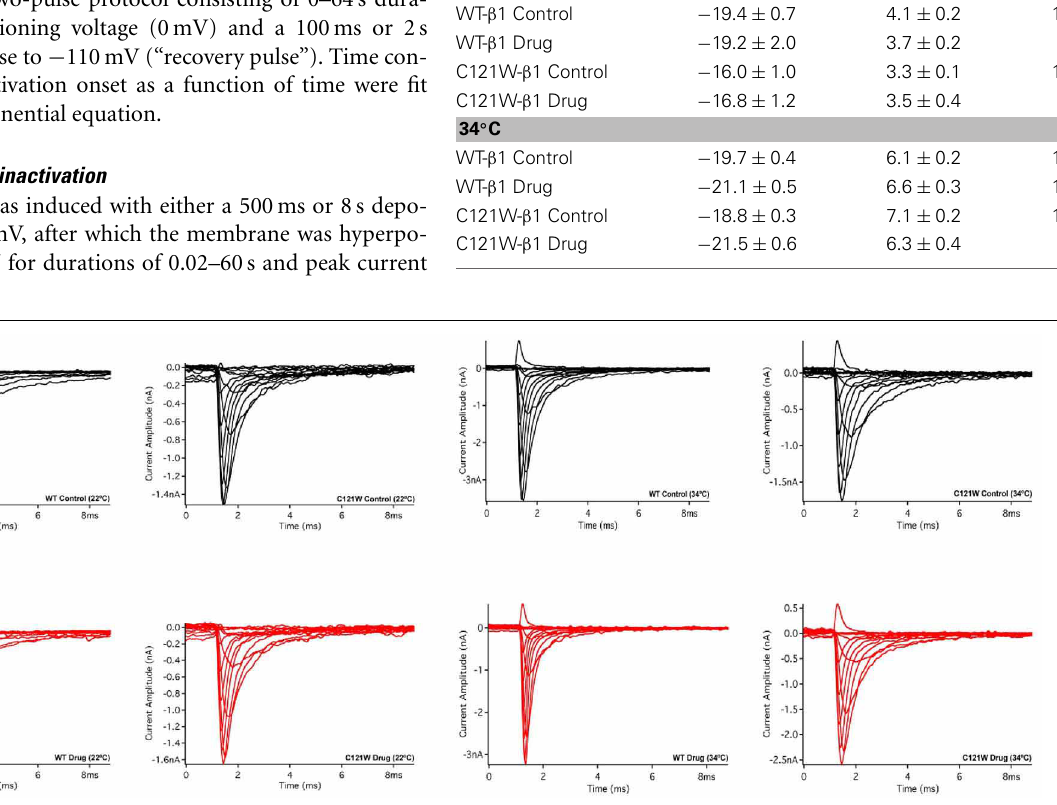
FIGURE 1 | Macroscopic currents. Current amplitude plotted verses time duration (ms). These traces were elicited by a set of alternating test pulses that range from − 80mV to + 60mV in increments of + 10mV.